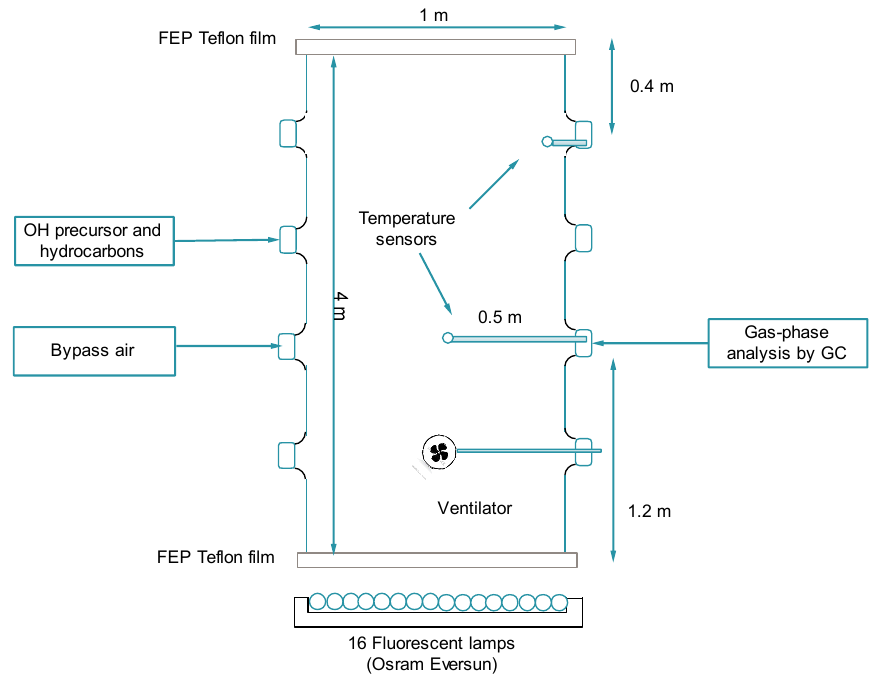
Figure 1. Schematic of the low temperature smog chamber facility. The hydrocarbons were injected into the smog chamber via syringes from two stock mixtures (see text), the gas-phase compounds were sampled through a stainless steel capillary and analyzed by GC-FID with sample enrichment (see below). Purified air was supplied via the aid of a bypass.